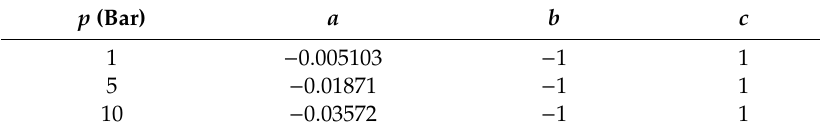
Table 3. Parameters of the empirical model according to the hydrogen pressure.